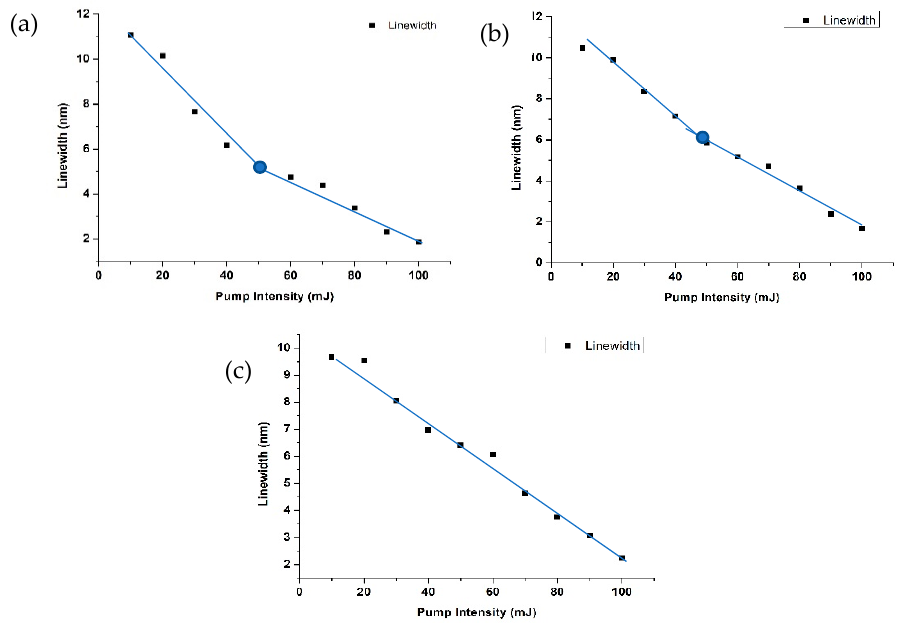
Figure 6. The emission linewidth of random lasers based on almond milk with various dye concen- trations: ( a ) 10 − 2 M, ( b ) 10 − 3 M and ( c ) 10 − 4 M. The lasing threshold is ~50 mJ for (a) and ~48 mJ for ( b ). No lasing threshold for ( c ). The linewidth is averaged from 10 emission spectra.